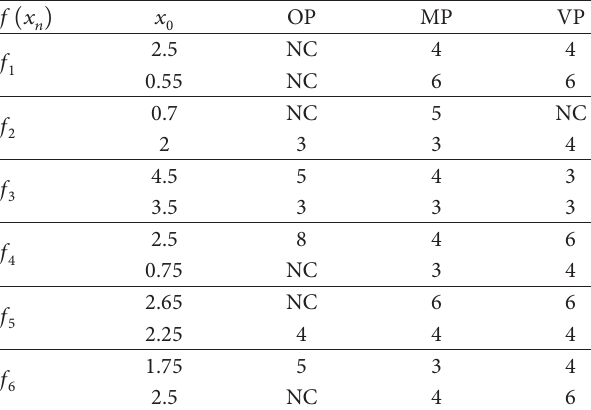
Table 1: OP represents ordinary perturbation iterations, MP rep- resents multiplicative perturbation iterations, and VP represents Volterra perturbation iterations. 𝑥 0 represent initial value. NC states that the given method does not converge for the given zero of function 𝑥 𝑒 .